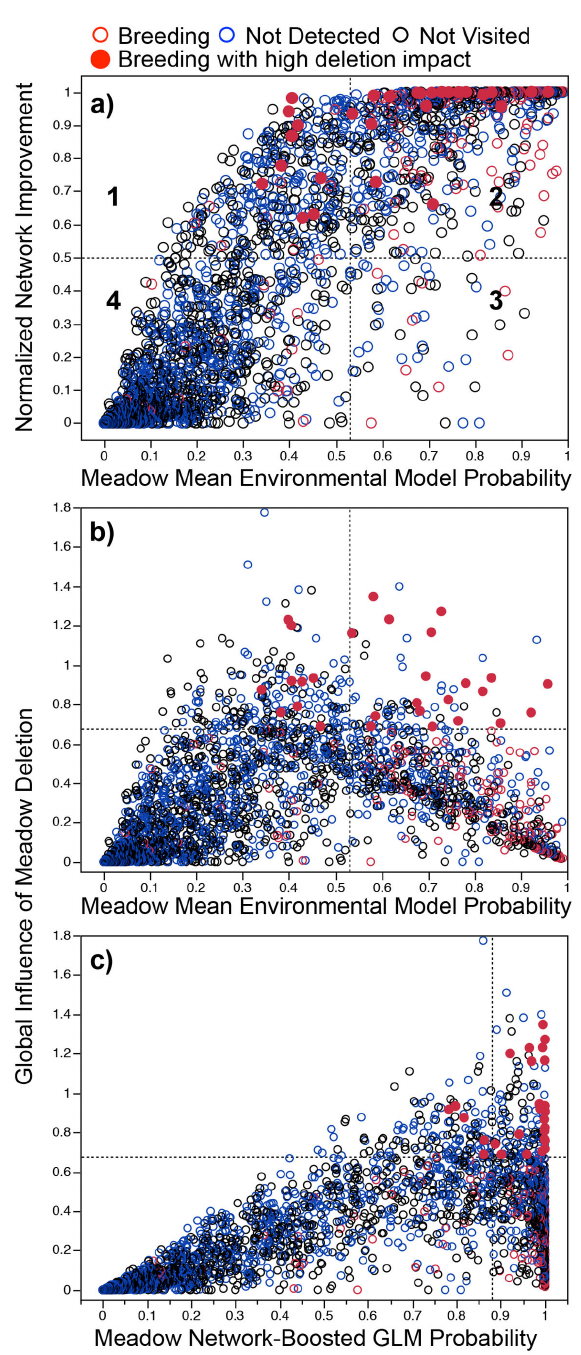
Figure 2. Disentangling intrinsic meadow ‘environmental quality’ from its spatial ‘network quality’ with respect to predicted A. canorus breeding. a) Normalized Network Improved breeding probabilities ((Network Boosted probability – Environmental Model probability) / (1 – Environmental Model probability)) for each meadow as a function of the mean Environmental Model probability. Symbol colors represent field survey results (Breeding detected (red), Breeding not detected (blue), and Meadow not visited (black). b-c) Total Influence (G ) of meadow deletion (the decrease in park-wide breeding probability summed across all i meadows after deleting that meadow from the network) as a function of the Environmental Model and the Network-Boosted GLM probabilities. Horizontal dotted lines indicate the 90 th percentile of meadow deletion impact, and solid red symbols are the known breeding meadows within that 90 th percentile. Vertical dotted lines in all panels represent the threshold probability that maximizes both true positives and true negatives predicted by the model. doi: 10.1371/journal.pone.0072200.g002 PLOS ONE |